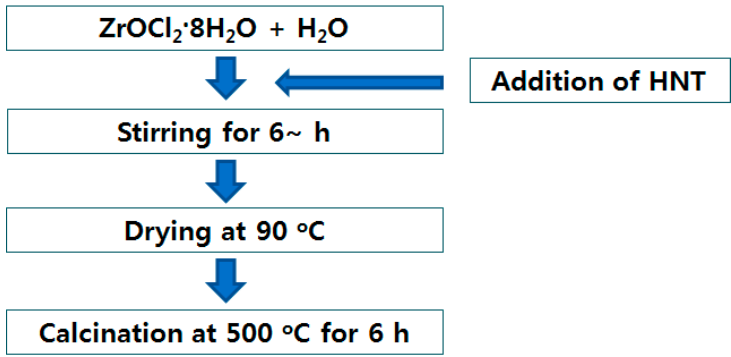
Figure 1. Schematic of the synthesis of Zr/HNT by wet impregnation.